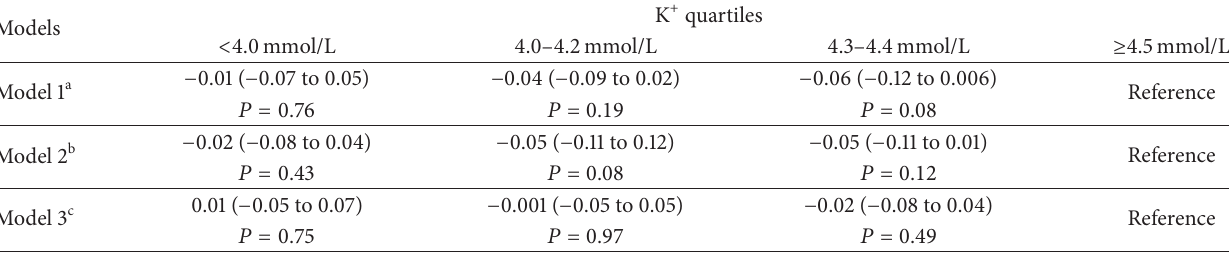
Table 4: Linear regression to determine the difference in fasting blood across K +